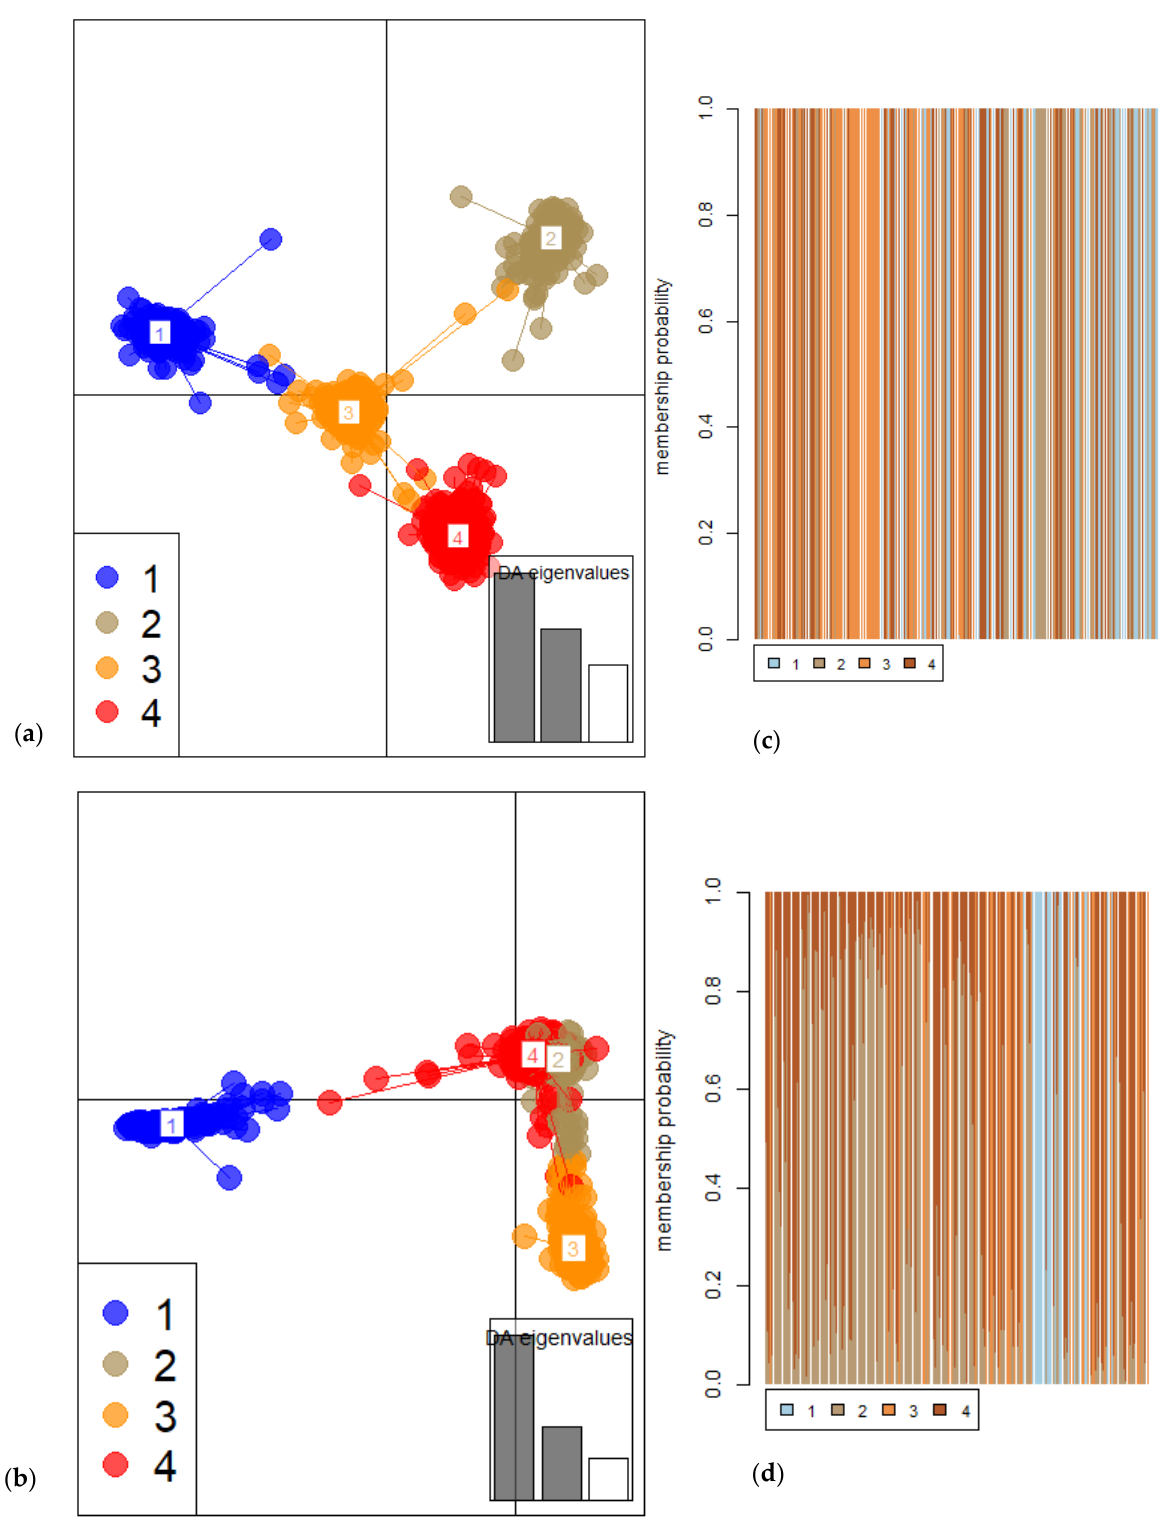
Figure 6. Discriminant analysis of principal components (DAPC) of the Sesbania sesban collection. Discriminant analysis by ( a ) SNP and ( b ) SilicoDArT markers. The cluster membership of individual sample inferred from discriminant analysis by ( c ) SNP and ( d ) SilicoDArT markers.